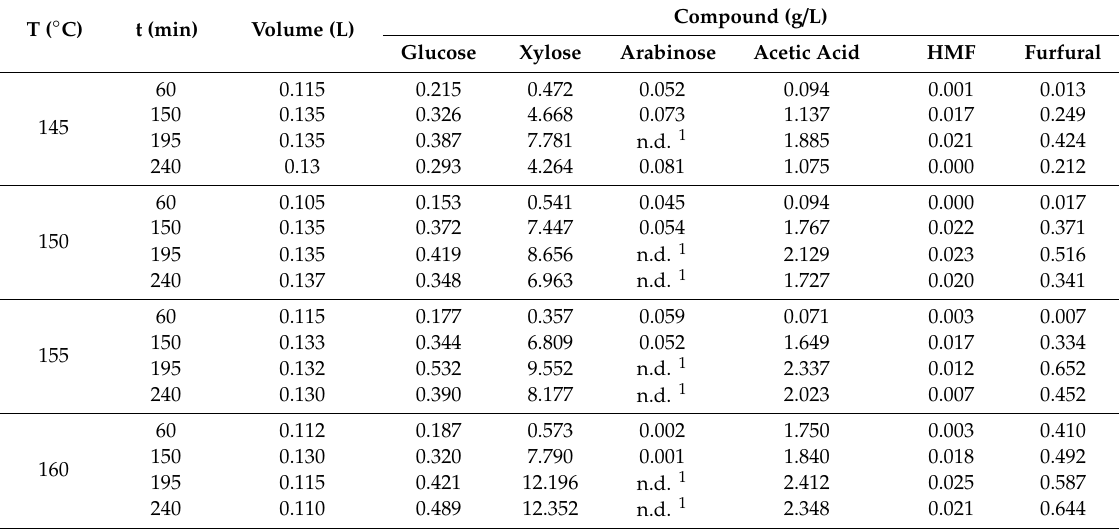
Table 4. Central composite design for cultivations with EHH at di ff erent C / N and C / P